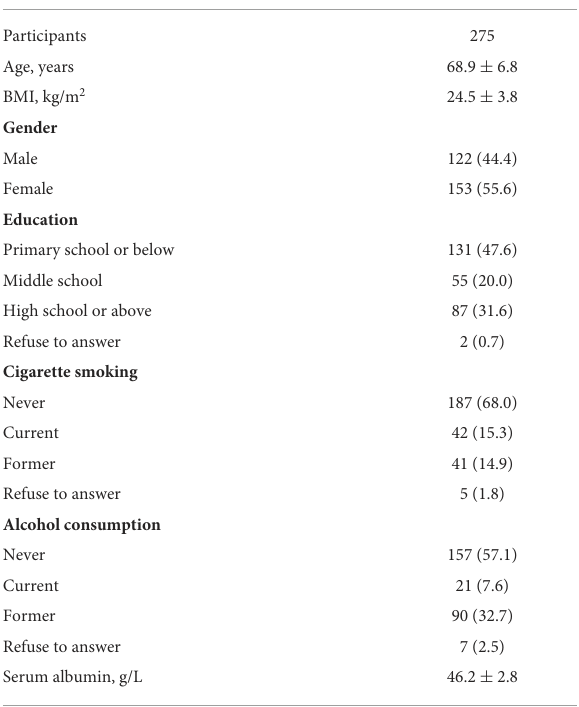
TABLE 1 Demographic characteristics and health status of participants throughout the study